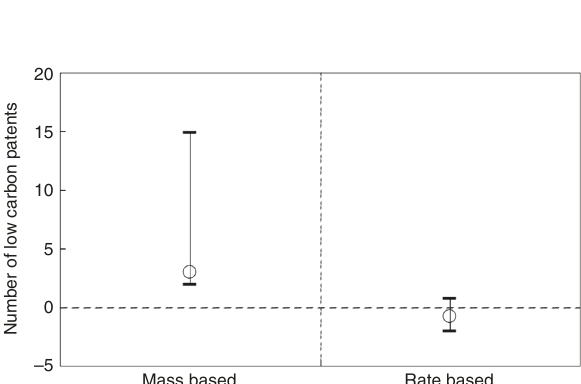
Fig. 4 ETS-induced Innovation under alternative allowance allocation approaches. ETS effects on the number of low-carbon patenting and 95% con fi dence intervals among fi rms under mass-based allocation and that under rate-based